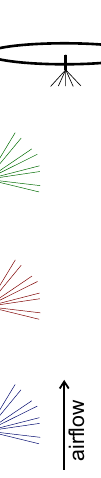
Figure 9. Product particle size distribution for two nozzles spraying downwards (Test A) and for lower nozzle spraying upwards (Test B) (adapted from Ref. [36]).